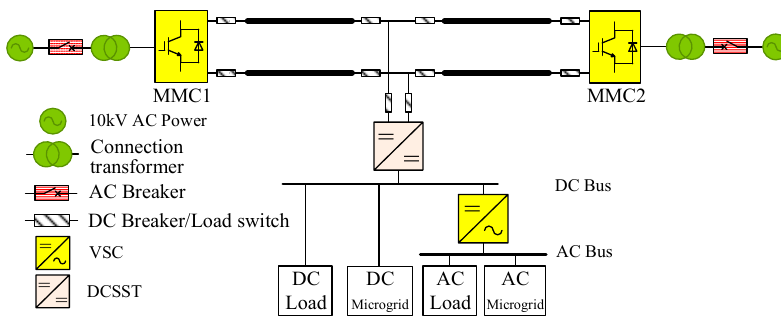
Figure 12. Topological structure of VSC-DC distribution system.